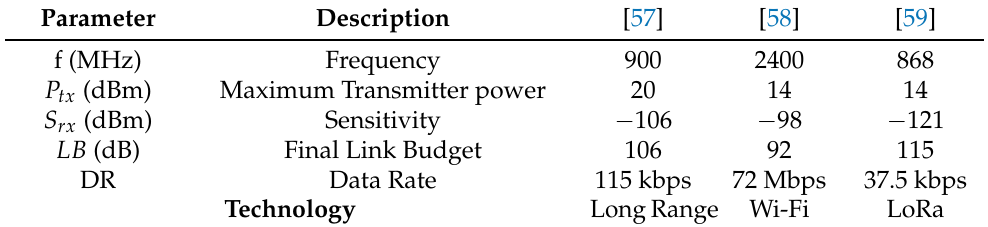
Table 1. Parameters of transceivers involved in the simulations.